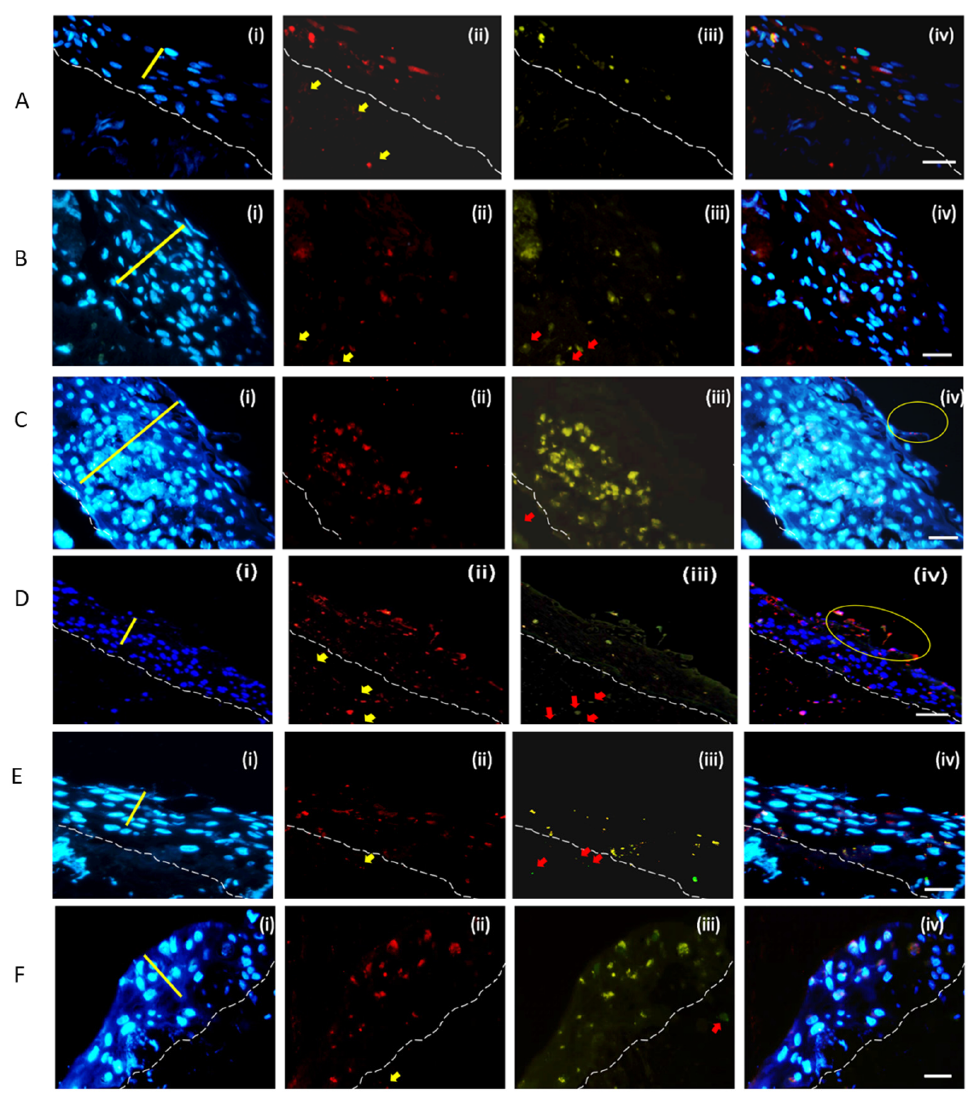
Figure 5. Images of a double-labelling of a cross-section of the skin model after 48 h infection with MRSA strain ST8 ( A ), ST30 ( B ), ST59 ( C ), ST22 ( D ), ST45 ( E ) and ST239 ( F ) using (i) DNA-binding Hoecsht stain (blue) to reveal the nuclei of the keratinocytes at the strata basale and spinosum, (ii) bacteria detected using anti- S. aureus antibody and Alexa Fluor ® 568 conjugated secondary antibody, (iii) the Click-iT ® TUNEL Alexa Fluor ® 488 cell. (iv) is an overlay of the emission signals. It shows co-localization of bacteria and apoptosis/DNA damage in keratinocytes in strata spinosum. White hashed line demarcates the dermal epidermal boundary between the stratum basale and the collagen gel populated with fibroblasts. The yellow line in (i) shows the stratum spinosum and applies across (i) to (iv). The yellow arrows in (ii) show the bacteria in the collagen gel. The yellow circles in (iv) show the exfoliation of the skin model. Scale Bar shows 50 µm and applies to (i) to (iv).